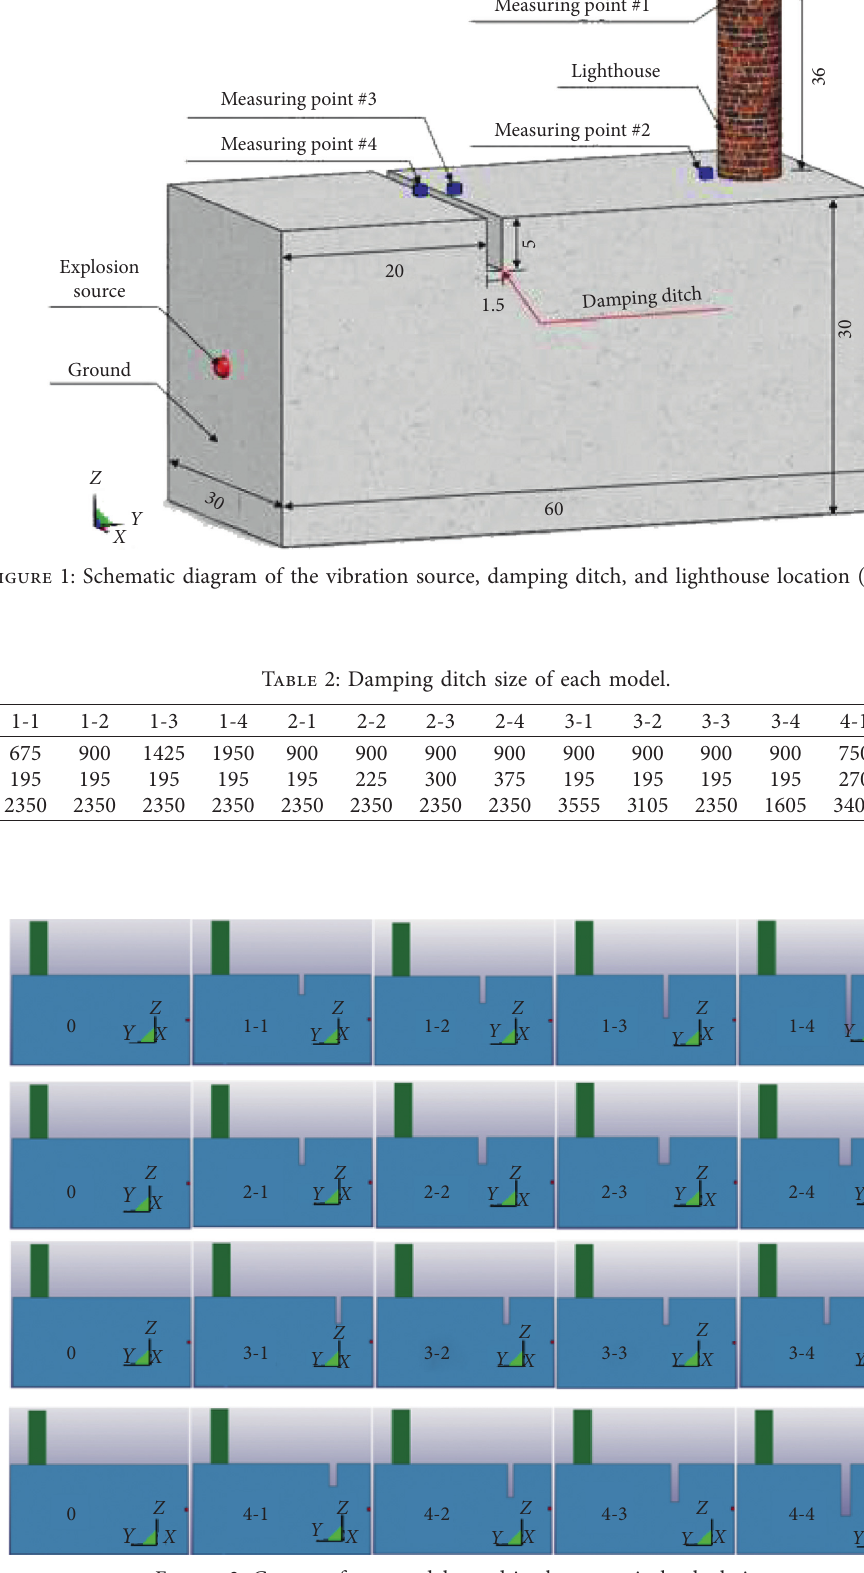
Figure 2: Groups of test models used in the numerical calculation.